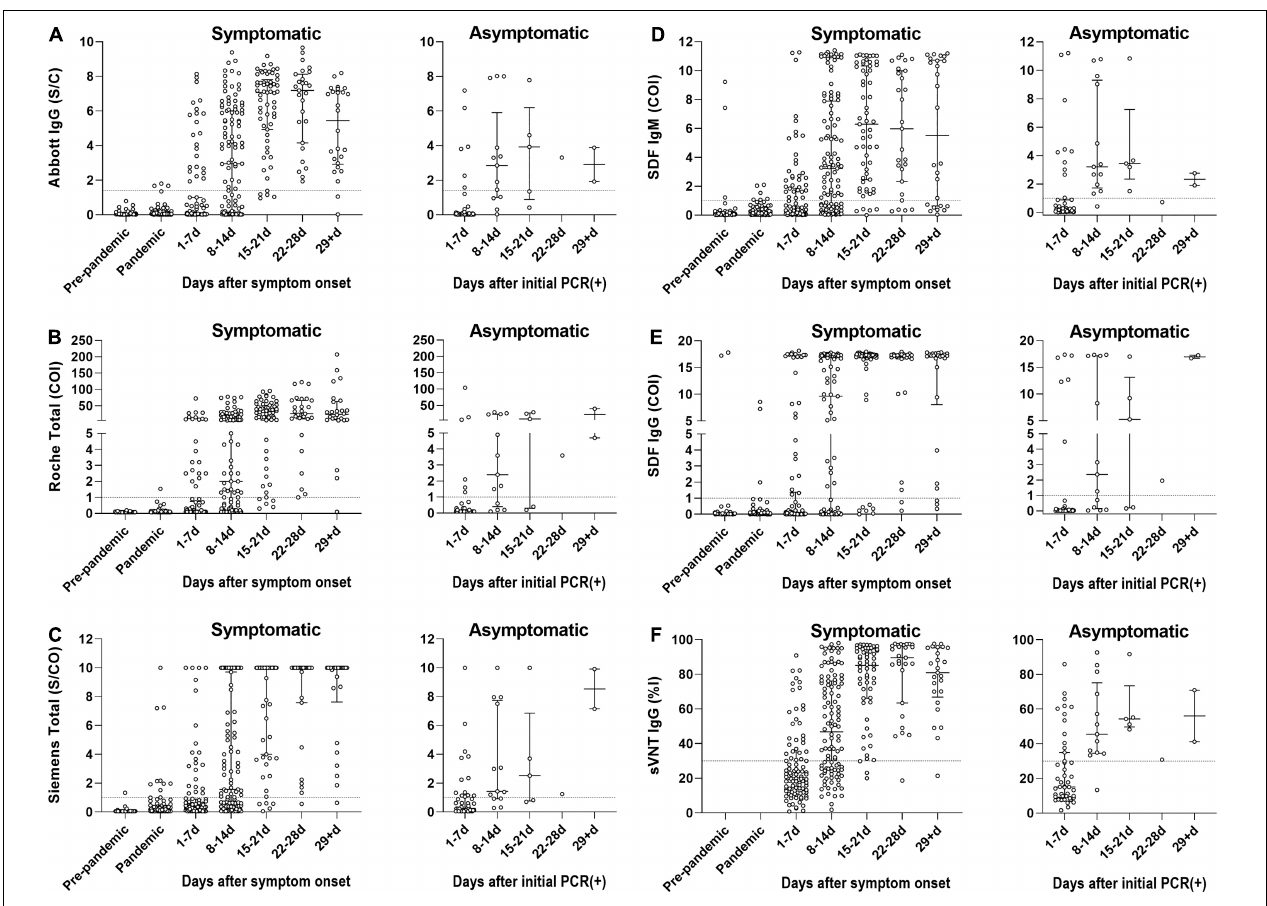
FIGURE 1 | The diagnostic sensitivities of SARS-CoV-2 antibody immunoassays in 389 samples from COVID-19-positive patients according to the presence or absence of symptoms and different time stages. The 321 samples from symptomatic COVID-19 patients were subdivided according to the number of days post symptom onset. The 68 samples from asymptomatic COVID-19 patients were subdivided based on days after initial RT-PCR detection. (A) Seropositivity of Abbott SARS-CoV-2 IgG (Abbott IgG). (B) Seropositivity of Roche Anti-SARS-CoV-2 (Roche Total). (C) Seropositivity of Siemens SARS-CoV-2 Total (Siemens Total). (D) Seropositivity of IgM of STANDARD F COVID-19 IgM/IgG Combo FIA (SDF IgM). (E) Seropositivity of IgG of STANDARD F COVID-19 IgM/IgG Combo FIA (SDF IgG). (F) Seropositivity of SARS-CoV-2 Surrogate Virus Neutralization Test (sVNT). The circle represents an individual sample. The dotted line indicates the cut-off value of each assay. The horizontal lines in scattered circles represent the median value with the interquartile range. COI, cut-off index; %I, percentage inhibition; PCR, polymerase chain reaction; S/C, sample/calibrator; S/CO,